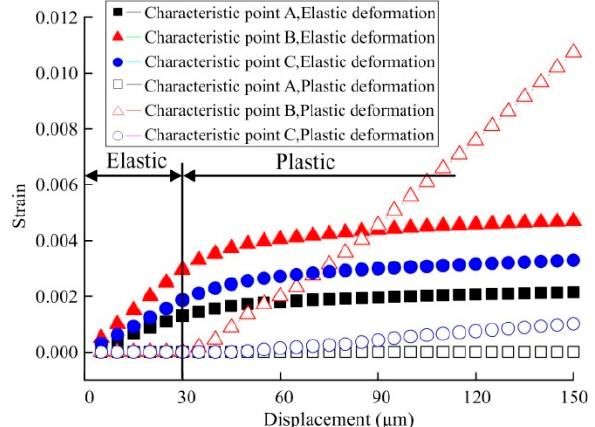
Figure 8. Displacement-dependent variation for strain of the specimen under biaxial tensile load.